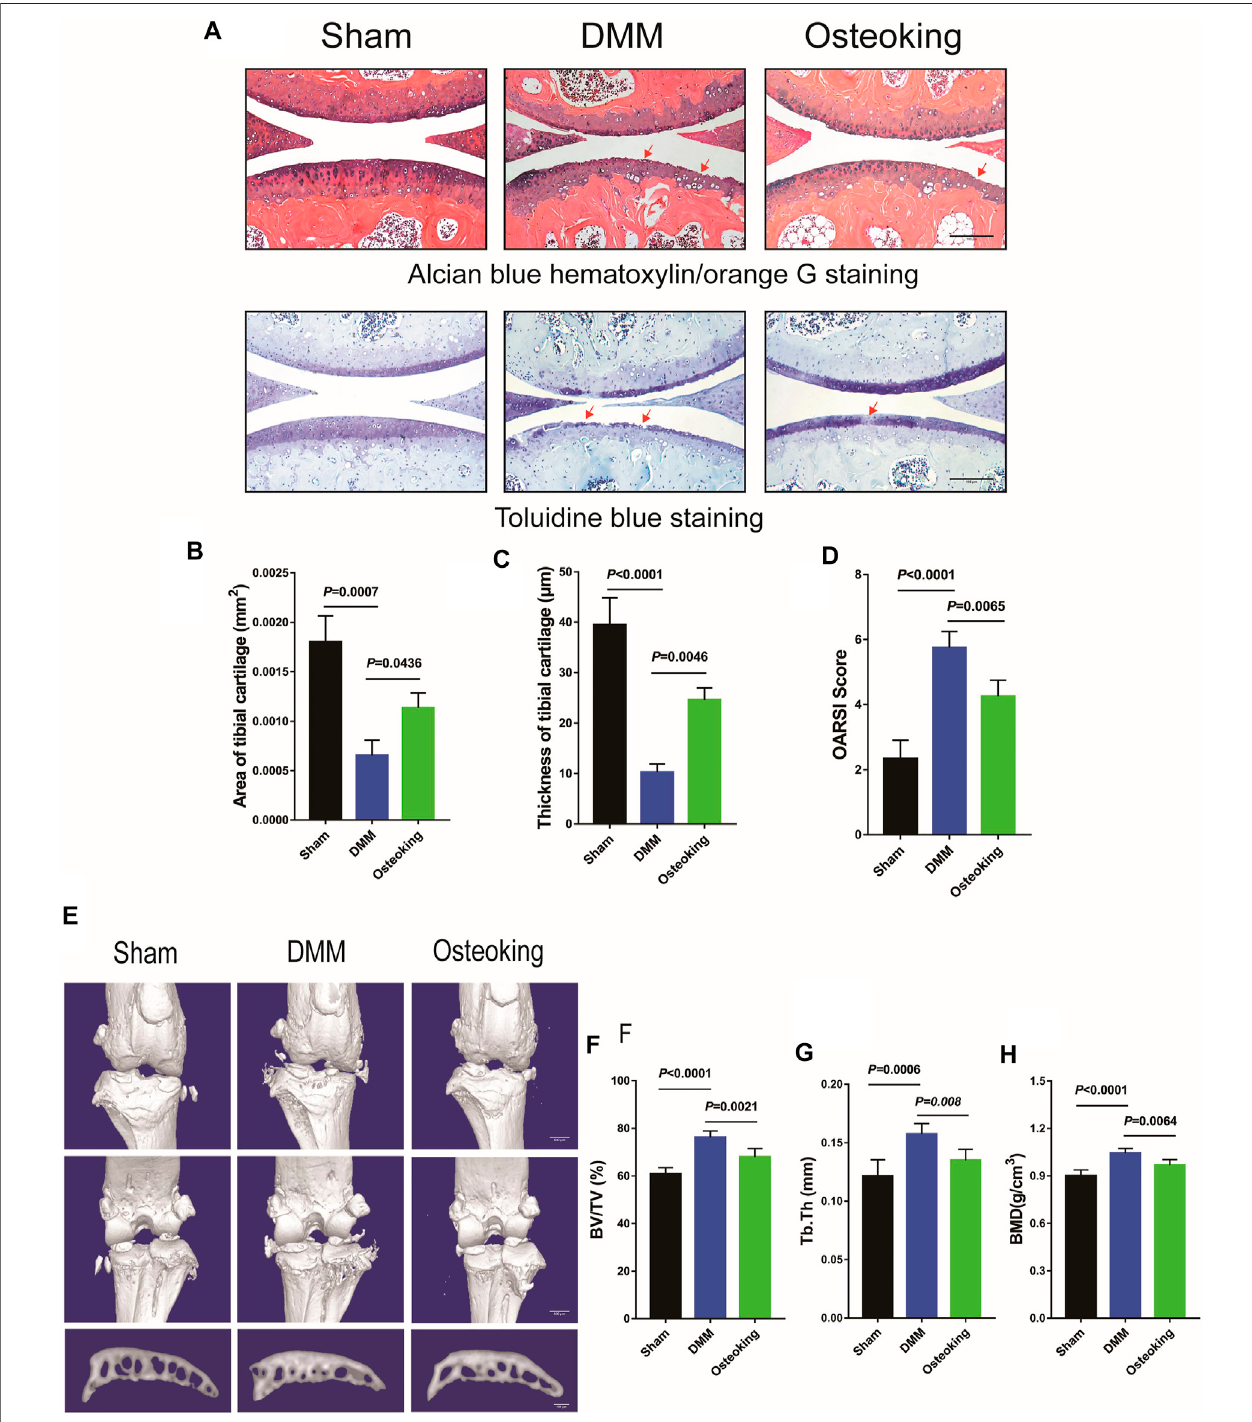
FIGURE 2 | Osteoking decelerated OA progression in a DMM-induced osteoarthritic model. (A) Alcian blue hematoxylin/orange G staining and Toluidine blue stainingoftherightkneejointinWTmice(surgicalone).Redarrowsindicatedtheareaofcartilageerosion.Scalebar (cid:2) 100 μ m.Morphologicalquantitativeanalysisof (B) area of tibial cartilage (mm 2 ) and (C) thickness of tibial cartilage ( μ m). (D) OARSI scoring of the sections analyzed by histomorphometry. Micro-CT was performed to analyzethechangesinbonestructure. (E) Representative3Dreconstruction oftheright kneejointand subchondralbone.Quantitative analysisofthesubchondral bone (F) BV/TV (%), (G) Tb.Th (mm) and (H) BMD (g/cm 3 ). Data were presented as means ± SD (n (cid:2) 10). The exact p value is presented in the corresponding graph.